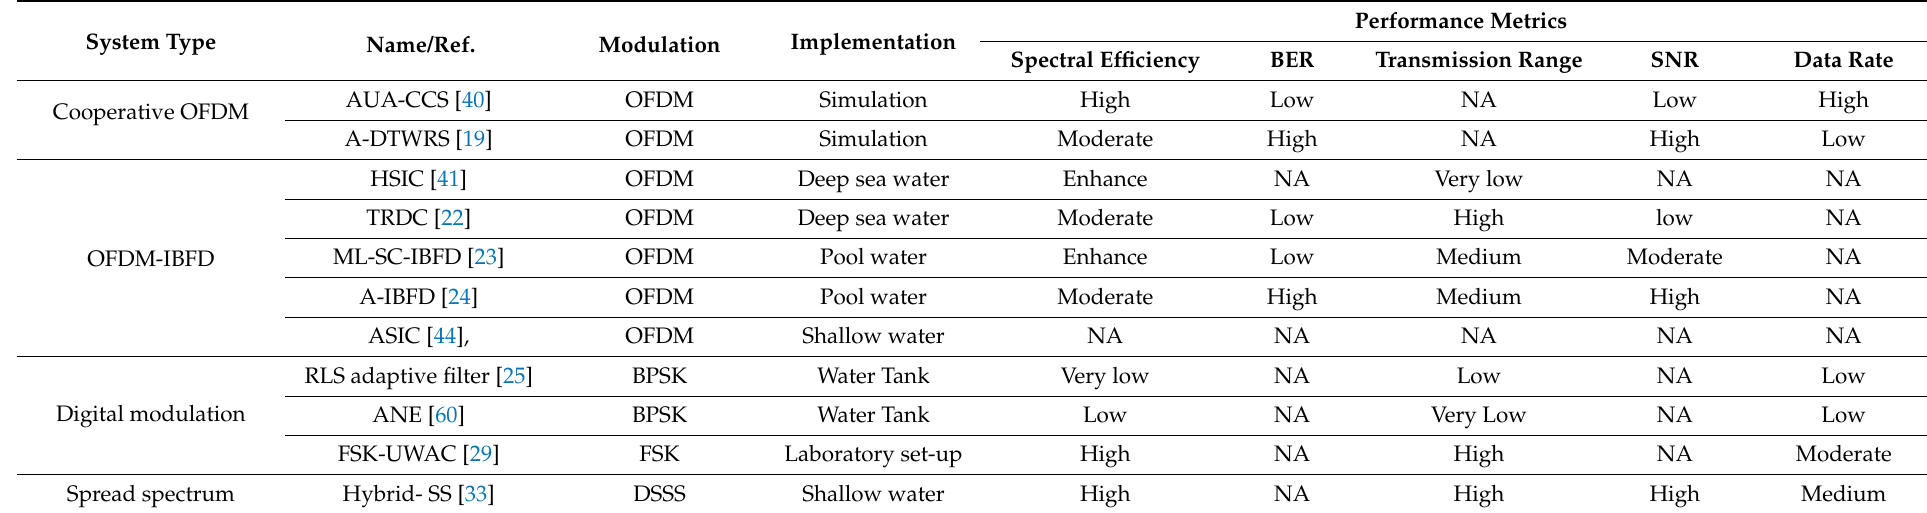
Table 1. Analysis of physical layer-based UWAC